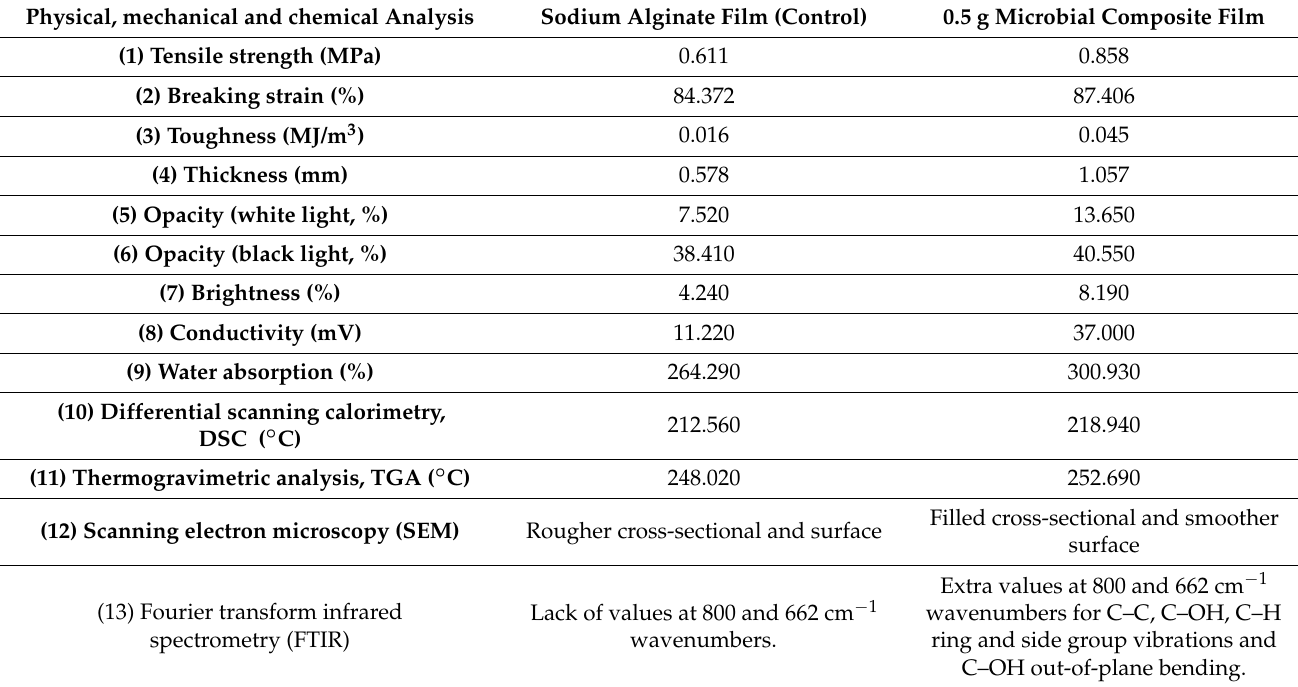
Table 6. Comparison between the properties of sodium alginate film (control) and 0.5 g microbial composite film. Physical, mechanical and chemical Analysis